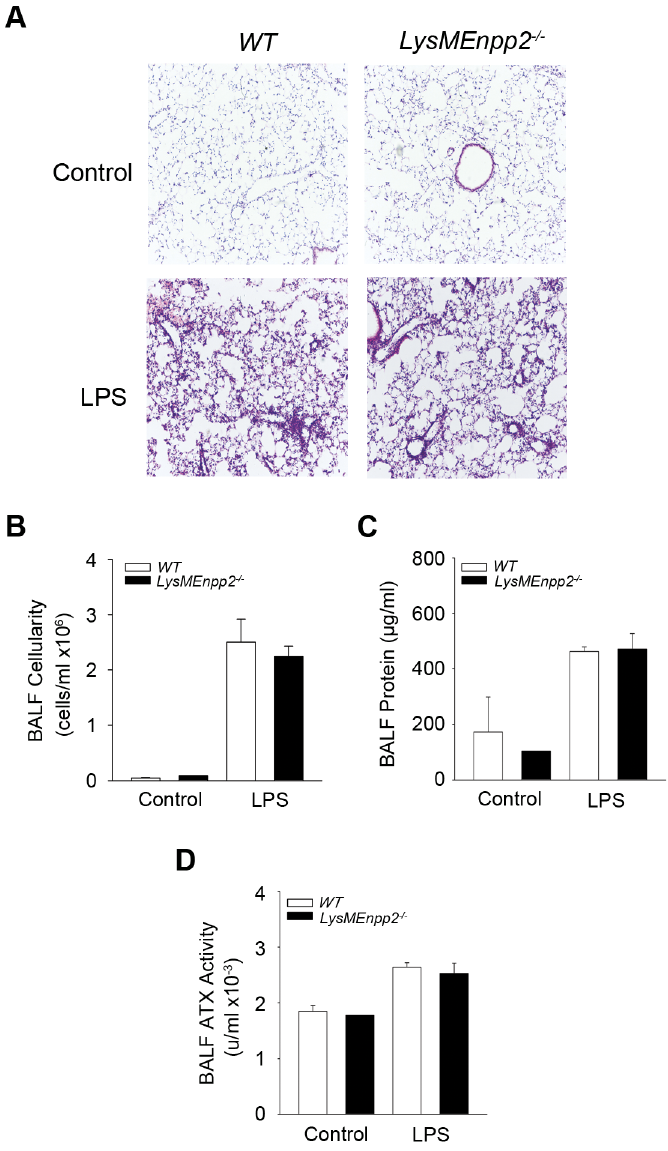
Fig 5. Deletion of ATX from myeloid cells had no effects in ALI development. Aerosolized LPS was administered in mice where ATX was deleted from the myeloid cells (LysMEnpp2 -/- ) and wild type littermate mice. Mice were sacrificed 24 hours later. A-C. Histological analysis (A) and BALF measurements (B & C) showed no differences in inflammation and edema between mice lacking ATX expression from myeloid cells and their wild type littermates. D. Conditional deletion of ATX from myeloid cells had no effects in BALF ATX